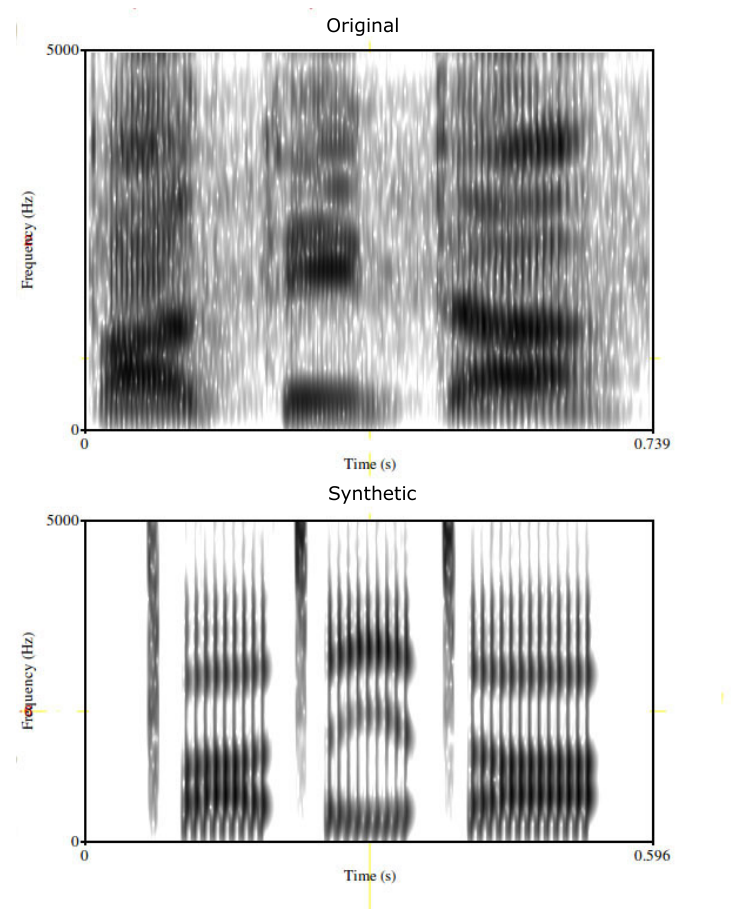
Figure 16. Spectrograms of the original ( top ) and artificial ( bottom ) word /p a t i t a/